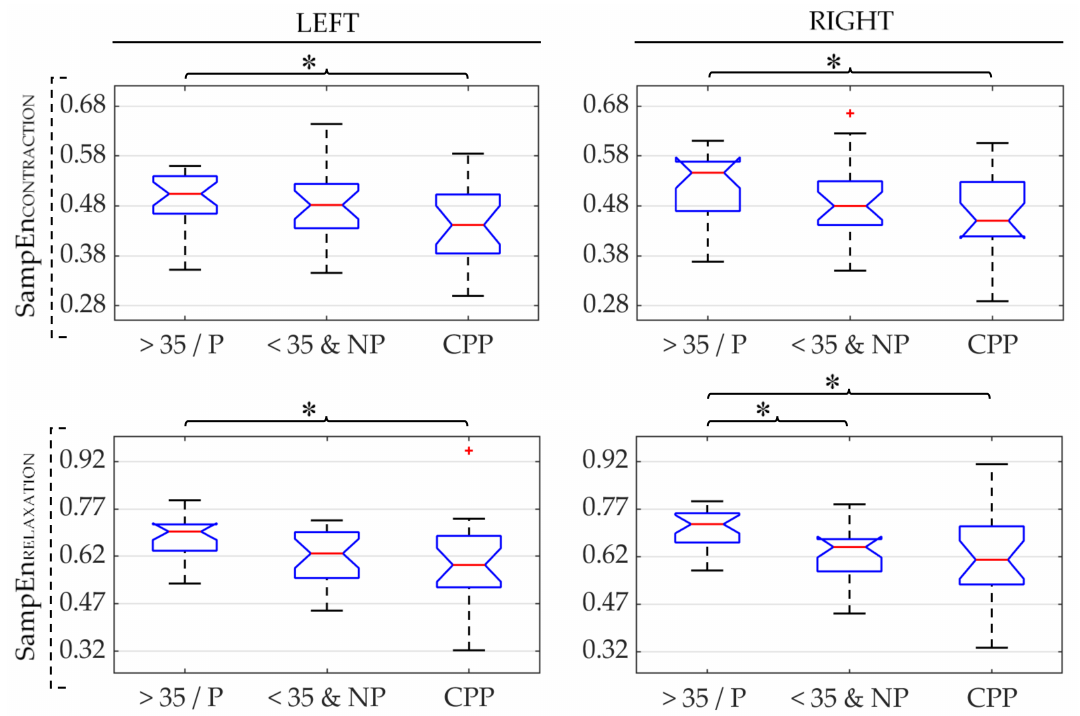
Figure 6. Box-whisker plots of sample entropy (SampEn) values of the left and right PFM (left and right subfigures, respectively) in patients (CPP), healthy women over 35 and/or parous (>35/P) and healthy women under 35 and nulliparous (<35&NP) during PFM contraction and relaxation (first and second rows, respectively). (*): significant difference between groups under the ends of the brace. Red (+): outlier within the group’s data